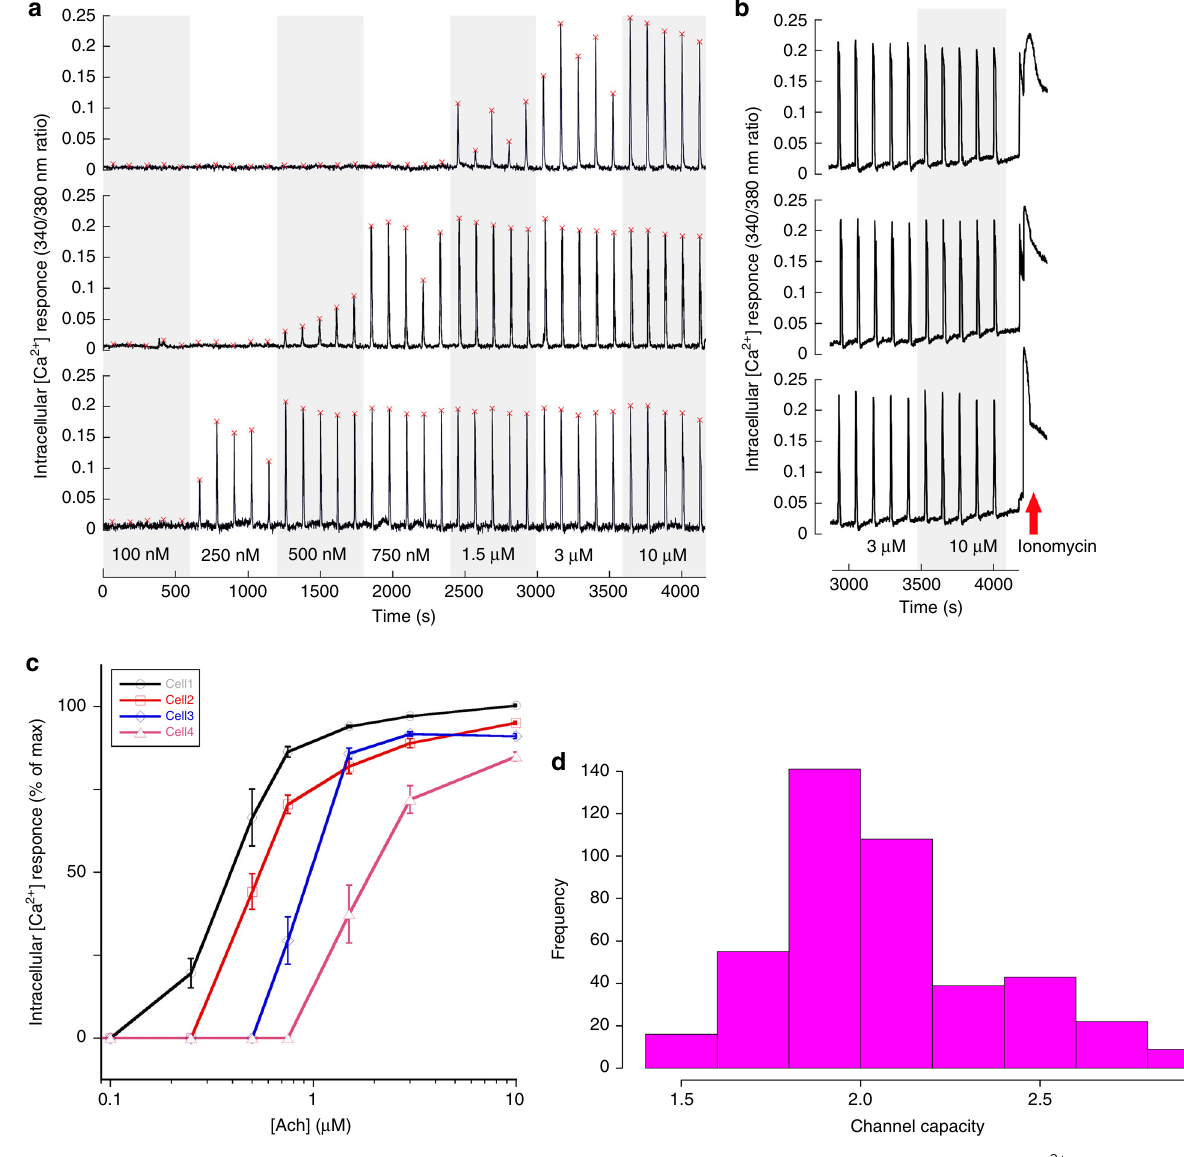
Fig. 3 Individual cells have individual dynamic ranges and high channel capacity. a Three examples of different single cell ’ s Ca 2+ responses to repeated stimulations with increasing concentrations of Ach. It is evident that some cells respond only to high Ach concentrations (top example), while others are sensitive already to the low concentrations but rapidly reach the plateau in their response strength (bottom example). The example in the middle is an intermediate. See also Fig. 2a. b To prove that cells indeed reach the plateau in their response capacity at high Ach concentrations, the Ca 2+ ionophore ionomycin (2 μ M) was added at the end of the experimental series in some experiments. Three examples are provided, illustrating the typical cell response to ionomycin. c Examples of cells possessing dynamic ranges shifted along the agonist concentration scale but all capable of responding reliably and differently to different agonist concentrations. d Histogram of estimated channel capacities estimates. The average estimate of channel capacity is 2.06 ± 0.31 (mean ± sd) bits, whereas the lower bound lies at 1.65 ± 0.18 (mean ± sd; see Supplementary Figure